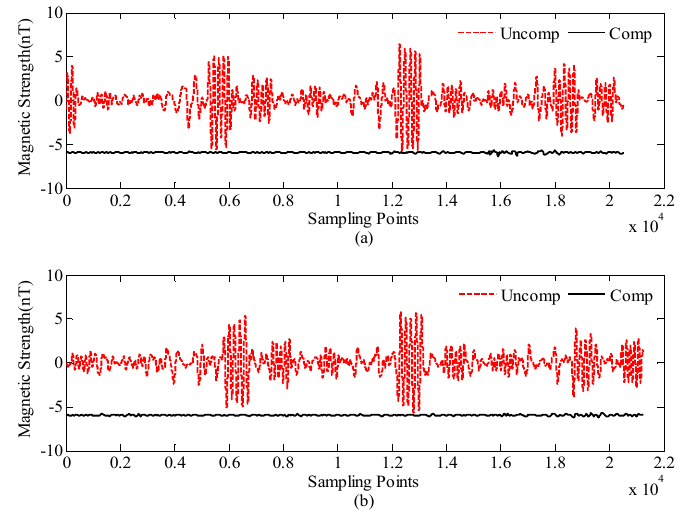
Figure 5. Compensation results of OPM-I: ( a ) calibration flight data and ( b ) test flight data.